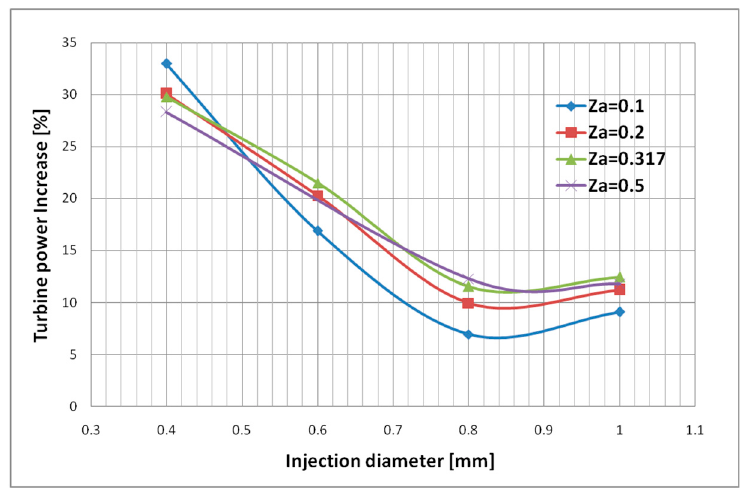
Figure 5. Turbine power increase after the injection process. The injected fluid acts as a barrier which diverts the working fluid from the suction side of the vane near the injection section. This deviation in the near vicinity of the critical section leads to a smaller flow section for the working fluid which translates into a higher speed and a higher power generated by the rotor. After the interactions between the fluids, the injected fluid assumes the direction of the main flow and attaches to the suction side of the blade. As a result of the injection process, a low-pressure zone downstream of the injection section is created due to the main fluid deviation. This effect can be observed in Figure 6, which presents the total pressure distribution at the mean radius of the vane for the cases with and without injection. Without the injection process the flow section of the vanes is approximately equal to the geometrical section, a small low-pressure zone being created by the boundary layer on the suction side. After the injection process the low-pressure zone is greatly enhanced which determines a noticeable smaller flow section. As a result, the effective geometry of the flow channel is modified. This effect is obtained across the vane height where the system is active, as can be determined from Figure 7. As the boundary conditions were set with a fixed mass flow at the rotor outlet, the power enhancement is not a result of a mass flow increase but a result of different flow geometry.